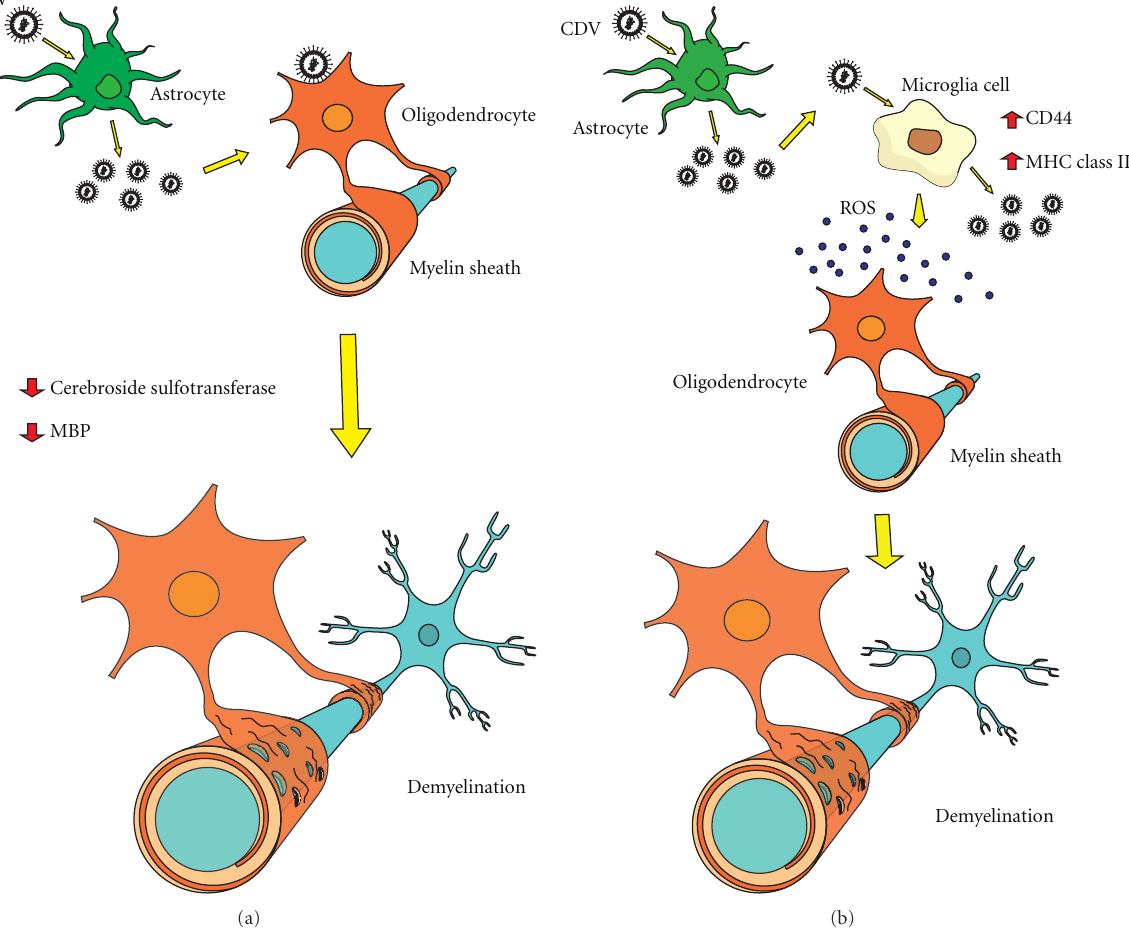
Figure 1: Schematic representation of the possible mechanisms involved in the demyelination process in the course of acute canine distemper disease. (a) Primary demyelination: direct action of CDV on oligodendrocytes. (b) Secondary demyelination: indirect action of CDV on oligodendrocytes and myelin sheath. CDV: canine distemper virus; PBM: myelin basic protein; ROS: reactive oxygen species (free